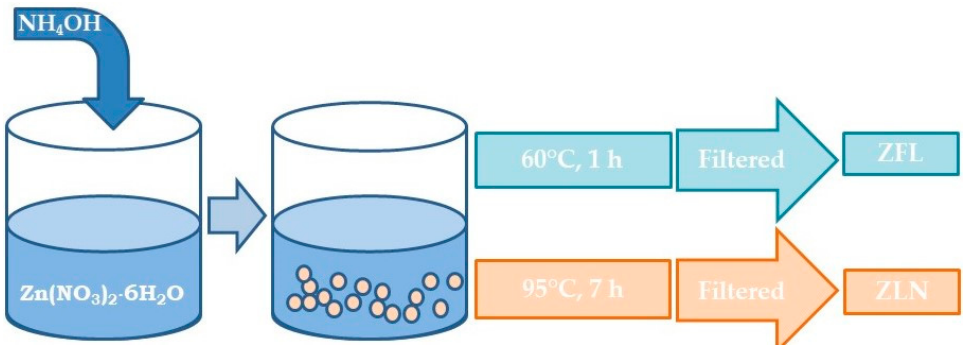
Figure 1. Schematic representation of nanostructured ZnO synthesis. ZFL = ZnO flower-like and ZLN = ZnO needle-like morphologies.